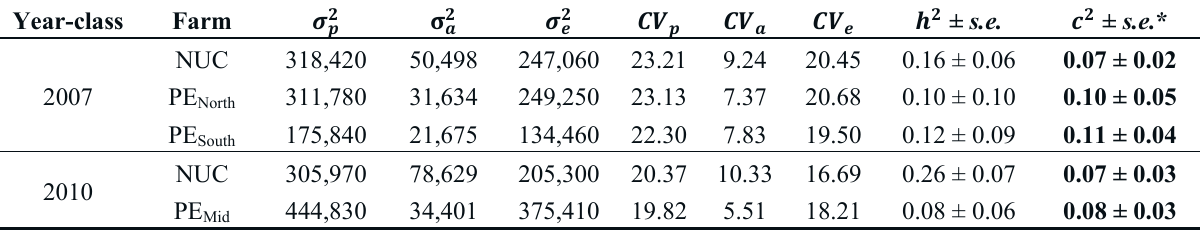
Table 2. Estimates of phenotypic ( σ (cid:3043)(cid:2870) ), additive genetic ( σ (cid:3028)(cid:2870) ), and residual ( σ (cid:3032)(cid:2870) ) variance, phenotypic ( (cid:1829)(cid:1848) ), additive genetic ( (cid:1829)(cid:1848) ), and residual coefficient of variance ( (cid:1829)(cid:1848) (cid:3043) (cid:3028) heritability ( (cid:1860) (cid:2870) ) and environmental variance common to full-sibs ( (cid:1855) (cid:2870) ) with their corresponding standard errors ( s.e. ) for body weight (BW) of Atlantic cod in different